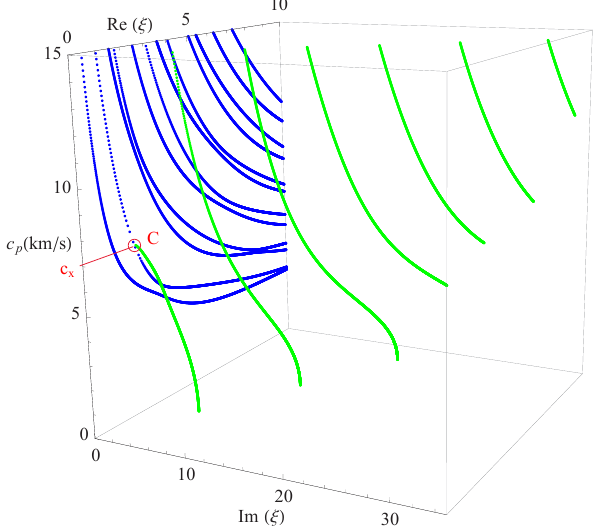
Figure 15. Three-dimensional phase velocity curves of the complex waves, blue branches for purely real solutions, and green for complex.